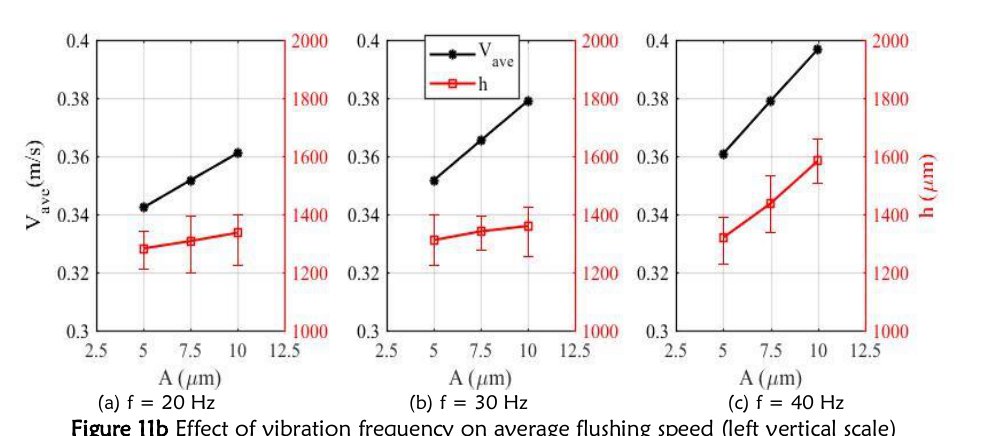
and machining depth (right vertical scale)